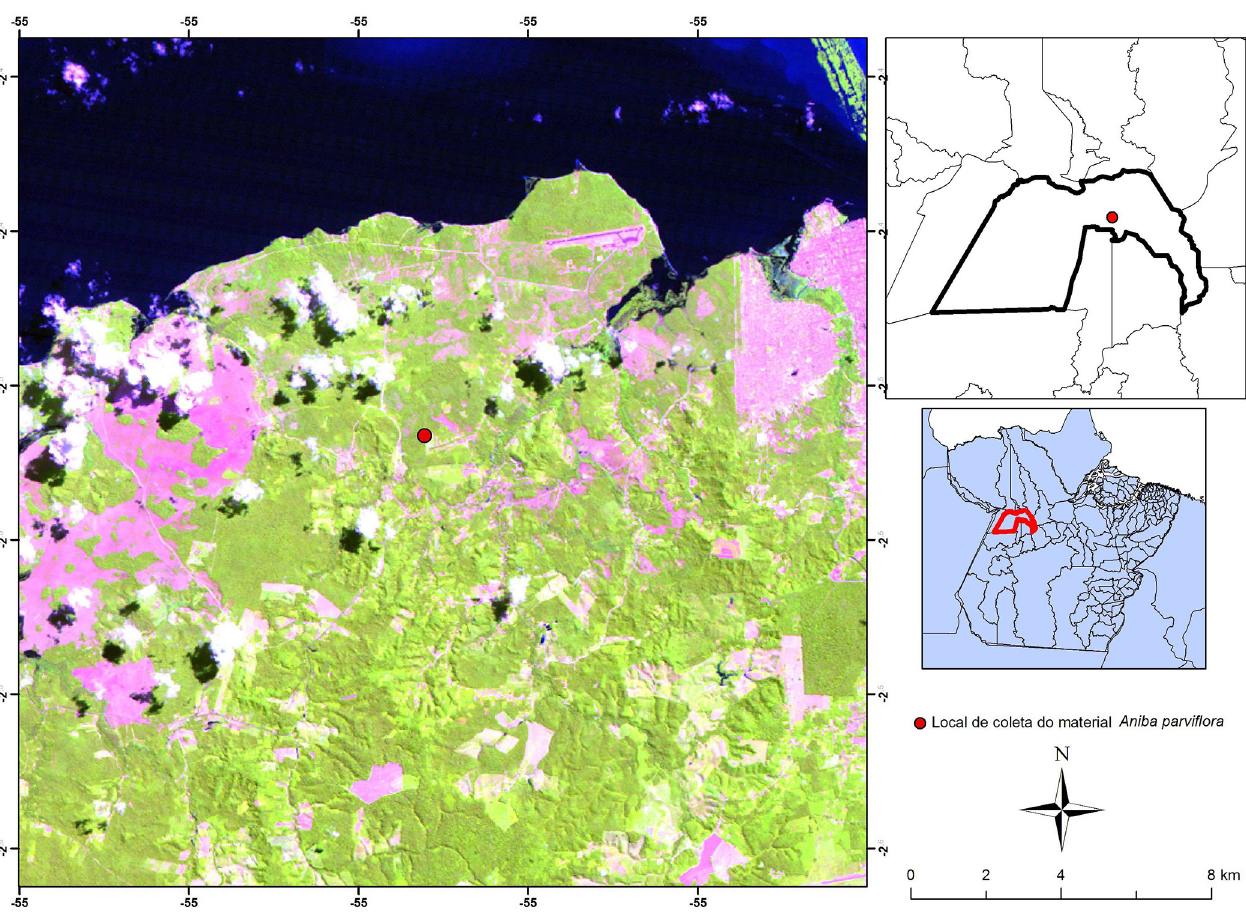
FIGURE 1 - Map of geographic coordinates of the soil sampling point rhizosphere of Aniba parviflora syn A . fragans (Macacaporanga) (Latitude 20 28 ‘01.28 “S Longitude 540 49’